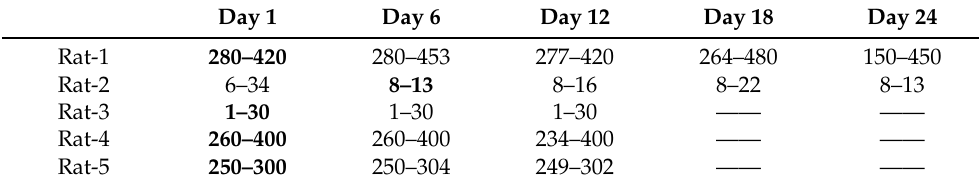
Figure 4. Channel and frequency band selection. ( A ) The QCCS matrix at the seizure onset of Rat-1. ( B ) The QCCS matrix at the seizure onset of Rat-2. The red box indicates the area with enhanced synchronization. ( C ) The frequency band selection results of all rats. Table 2. The frequency